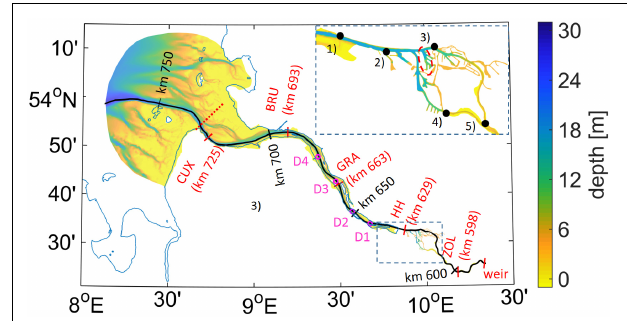
FIGURE 1 | Model domain with depth [m] given as a background. The black transect line indicates the Elbe navigational channel, with black labels identifying the official Elbe-km. Red labels and associated ticks mark the locations of observation stations for (but not only) water quality parameters, with respective official Elbe-km given as additional information. Purple circles mark the locations of permanent moorings where horizontal currents, salinity, and temperature are measured, with purple labels D1–D4 identifying the individual stations. The inset in the upper right corner indicates the locations of gauges in the region of the port of Hamburg used for model validation: (1) Blankenese, (2) Seemannshöft (labeled “HH”), (3) Sankt Pauli, (4) Harburg, and (5) Bunthaus. The red dashed line marks a port basin subject to analysis in Figure 11